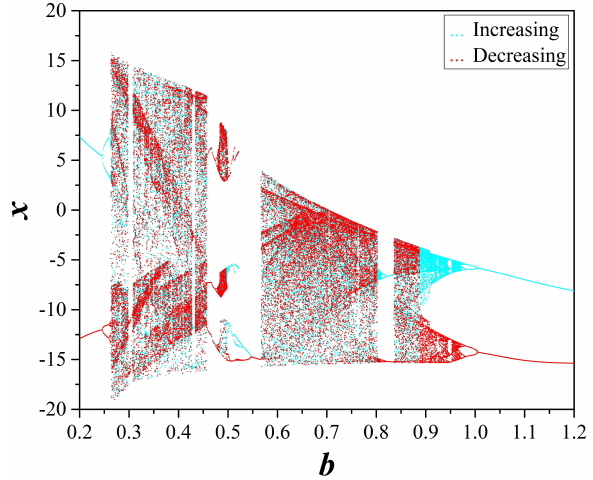
Figure 3. Continuation diagrams of system (2), when parameter b is increased (red) and decreased (blue).